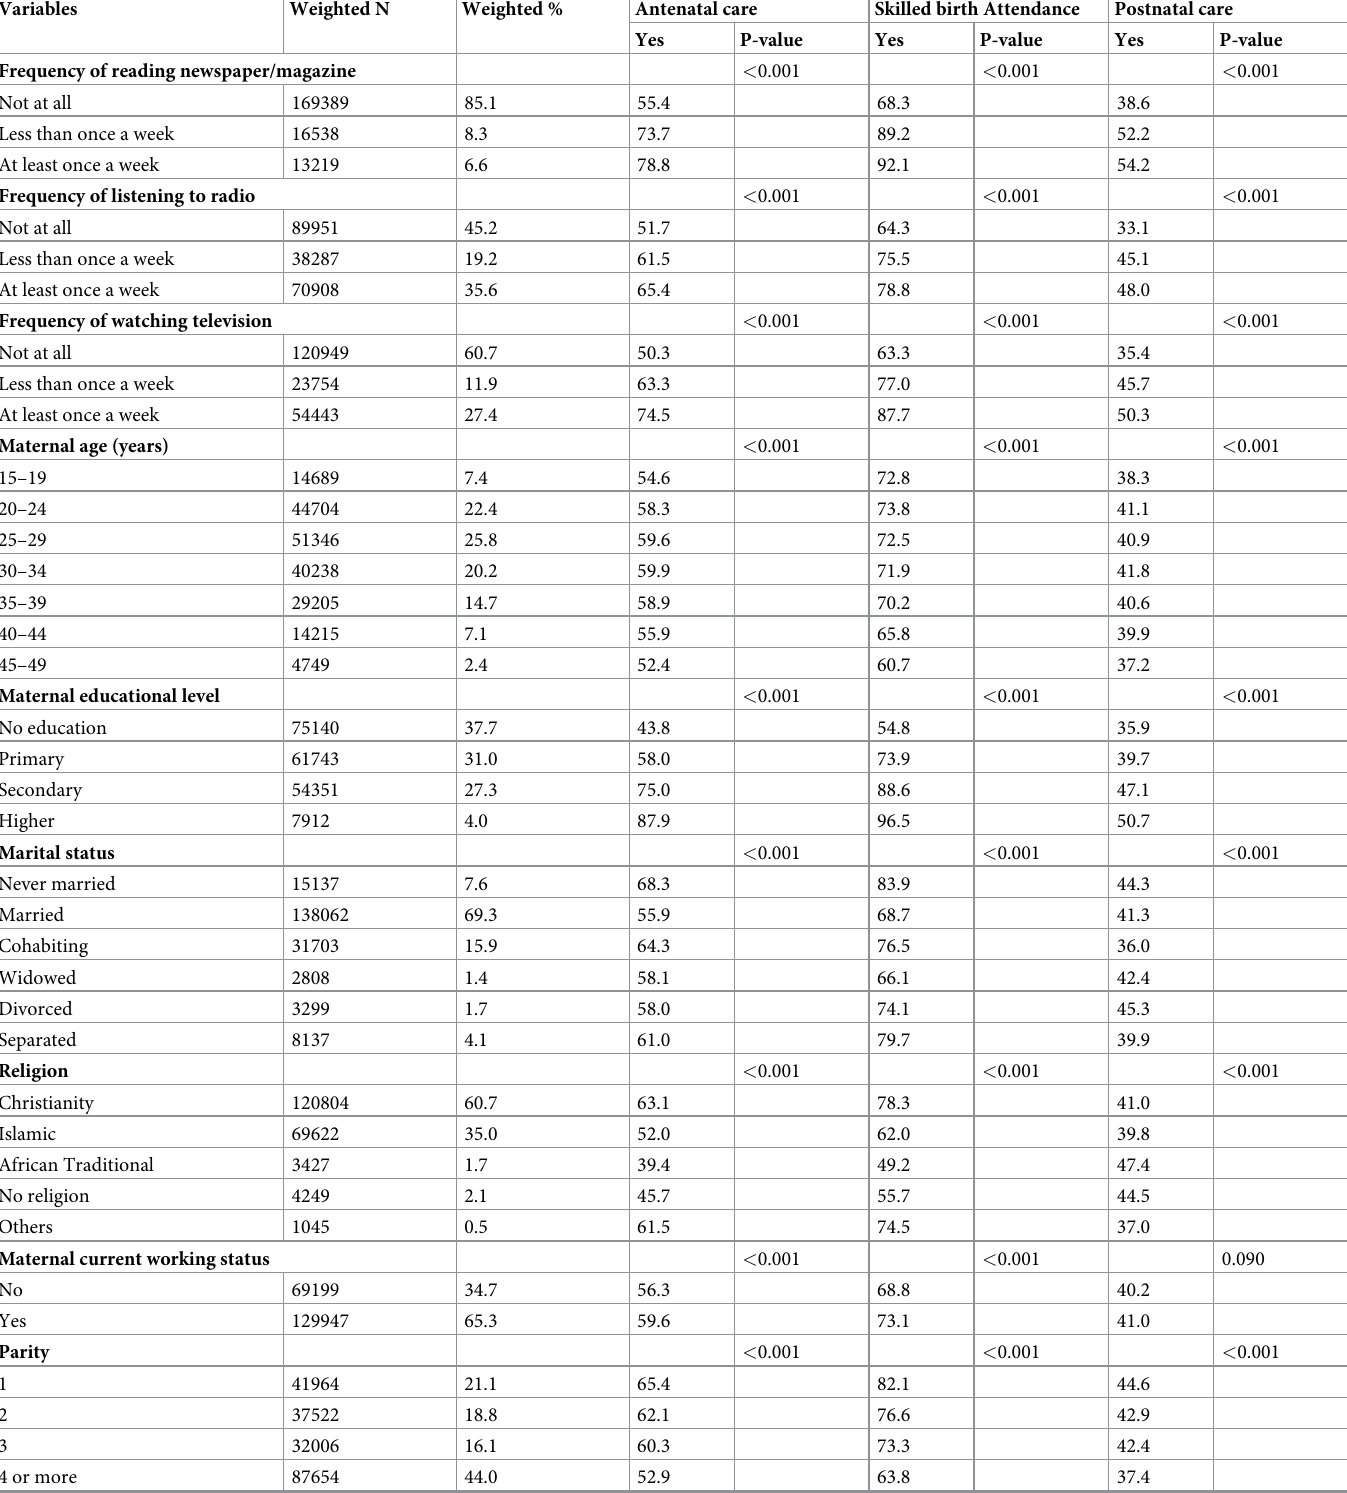
Table 2. Distribution of maternal health care service utilisation across explanatory